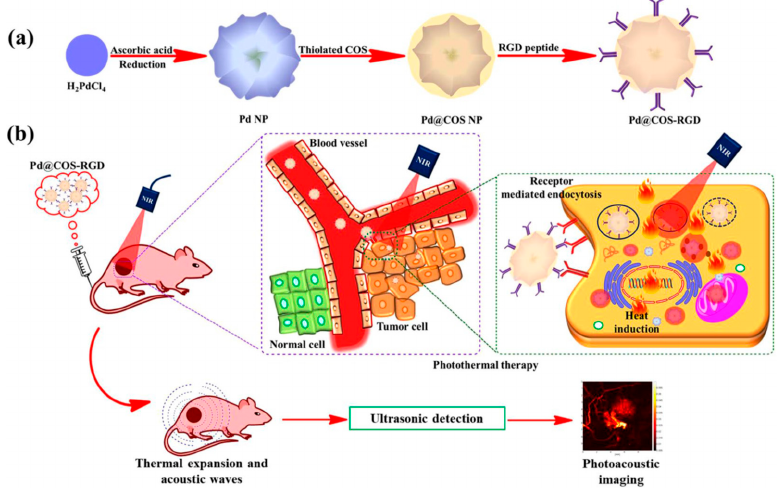
Figure 3. Chitosan-oligosaccharide-coated biocompatible palladium nanoparticles (Pd@COS NPs) for photo-based imaging and therapy. ( a ) A scheme showing the preparation of Pd NPs, further surface coating with thiolated chitosan oligosaccharide (Pd@COS NPs), and finally, functionalization using an RGD peptide (Pd@COS ‐ RGD). ( b ) A systematic illustration showing the photothermal ablation and photoacoustic imaging of tumor tissue using Pd@COS ‐ RGD. (Reprinted from [69], license CC BY 4.0.)